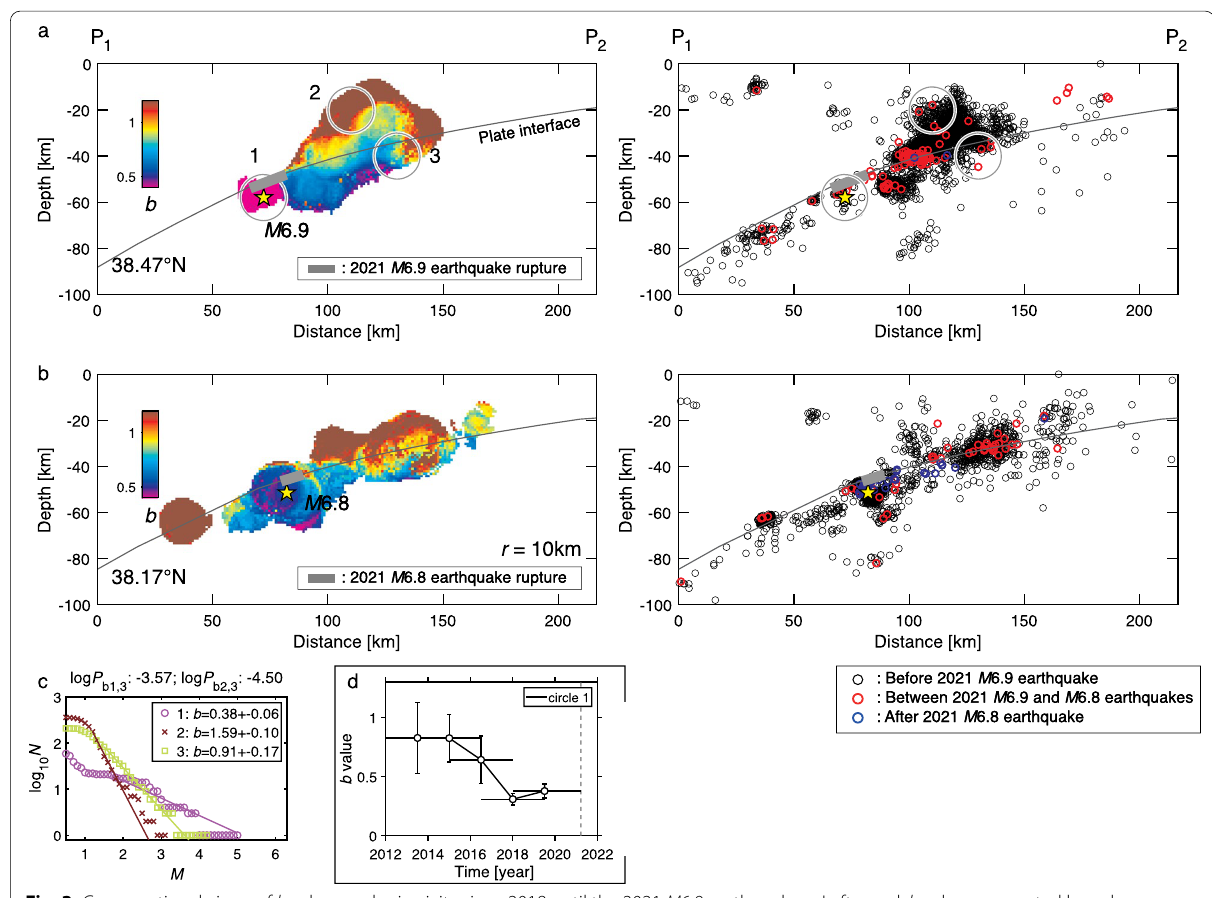
Fig. 3 Cross-sectional views of b values and seismicity since 2018 until the 2021 M 6.9 earthquake. a Left panel: b values computed based on seismicity along the line segment “A” in Fig. 1b. To create this figure, we project sampled earthquakes onto a vertical plane extending from P 1 to P 2 in Fig. 1b, roughly perpendicular to the Japan trench axis (Fig. 1a). At each grid node (1 km grid spacing), we selected all events within a search radius of 10 km and considered a swath width of 10 km, resulting, at each grid node, in a cylindrical sample volume of 20 km diameter and 10 km depth. Black curve indicates the upper surface of the Pacific plate (Nakajima and Hasegawa 2006). Grey segments indicate the rupture areas of the 2021 M 6.9 and M 6.8 earthquakes (Tohoku University 2021a) (hypocenters indicated by stars). Right panel: black, red, and blue circles represent seismicity before the 2021 M 6.9 earthquake, between the 2021 M 6.9 and M 6.8 earthquakes, and after the 2021 M 6.8 earthquake, respectively. b Same as a for the cross-section along the line segment “B” in Fig. 1b. c Events within the three circles of radius r 10 km, indicated by “1”, “2”, and “3”, are used to = show a fit of the GR law to observations. Color corresponds to the b value indicated by the color bar. The uncertainty estimates are according to Shi and Bolt (1982). log P b1,3 is the logarithm of the probability that the b values for the circles 1 and 3 are not different and log P b2,3 is the same as that for circles 2 and 3. d Plot of b values as a function of time for circle